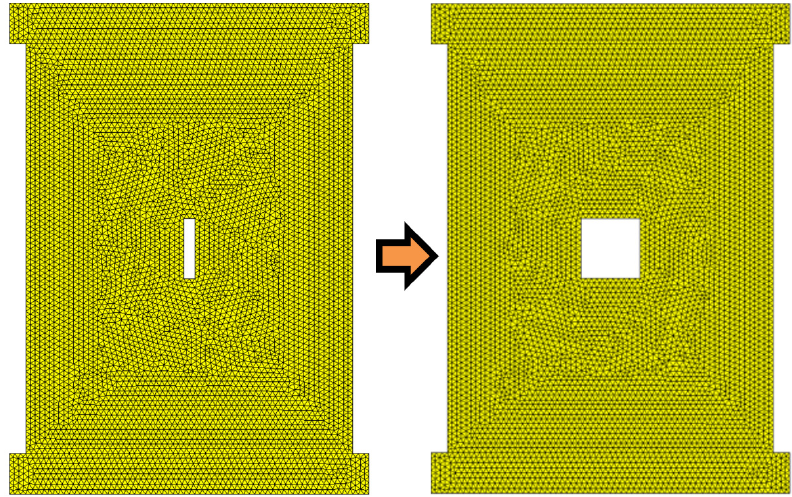
Figure 10. The width of hole w increases from 1 mm to 22 mm.